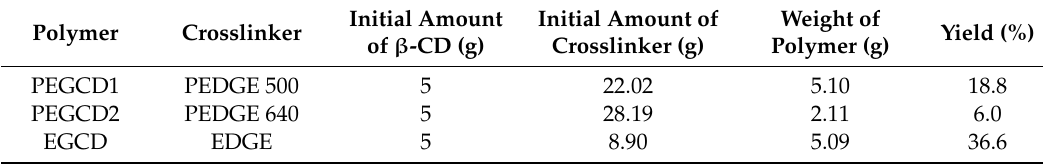
Table 1. Experimental conditions for polymer